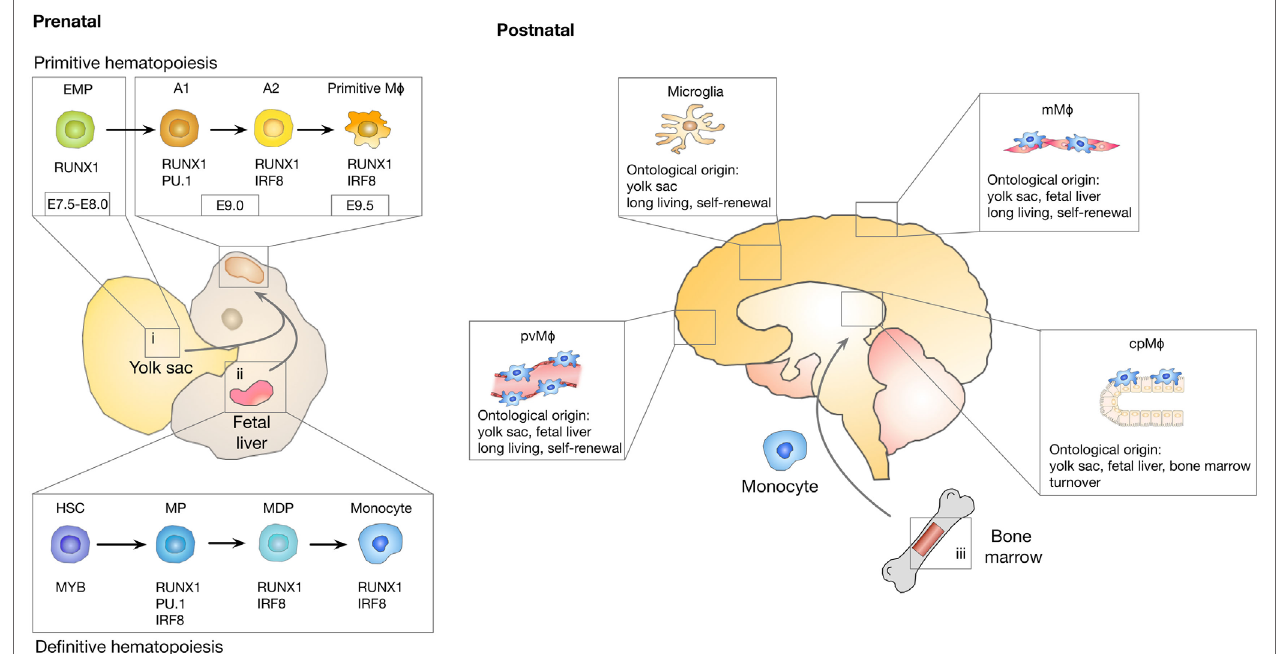
FiGURe 1 | Ontological origin of macrophage subpopulations in the central nervous system (CNS). A first wave of myeloid cell development takes place in the yolk sac (i) between E7.0 and E8.0 in a process known as primitive hematopoiesis that leads to the generation of erythro-myeloid progenitor (EMP) cells. EMP cells give rise to A1 (cKit + Cx3cr1 − ) cells followed by A2 (Cx3cr1 + ) cells that differentiate into microglia, perivascular macrophages (pvM ϕ ), meningeal macrophages (mM ϕ ), and choroid plexus macrophages (cpM ϕ ). Microglia originate exclusively from yolk sac-derived progenitors, while non-parenchymal CNS macrophages are replenished with fetal liver-derived progenitor cells (ii) as part of definitive hematopoiesis. Perinatally, hematopoiesis starts to be restricted to the bone marrow (iii). Among the CNS macrophages, cpM ϕ are the only population with substantial constitution from bone marrow progenitors. Microglia, pvM ϕ , and mM ϕ are considered to be long-living cells that regenerate through